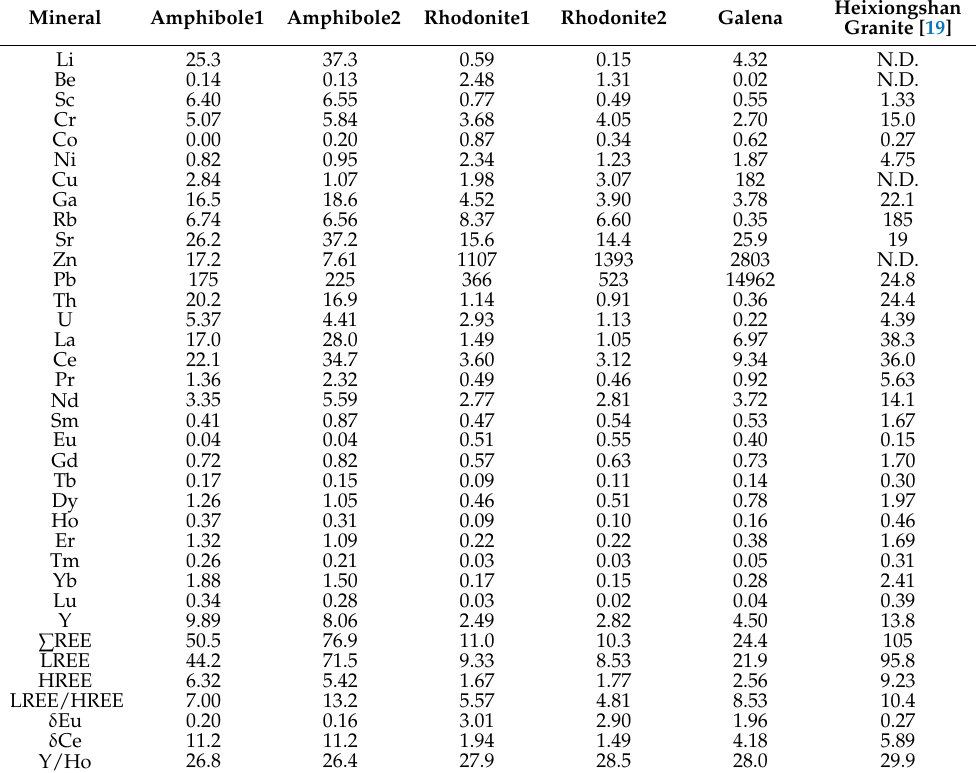
Table 2. Trace elements and REE compositions (ppm) of the rhodonite, amphibole, and galena. Mineral